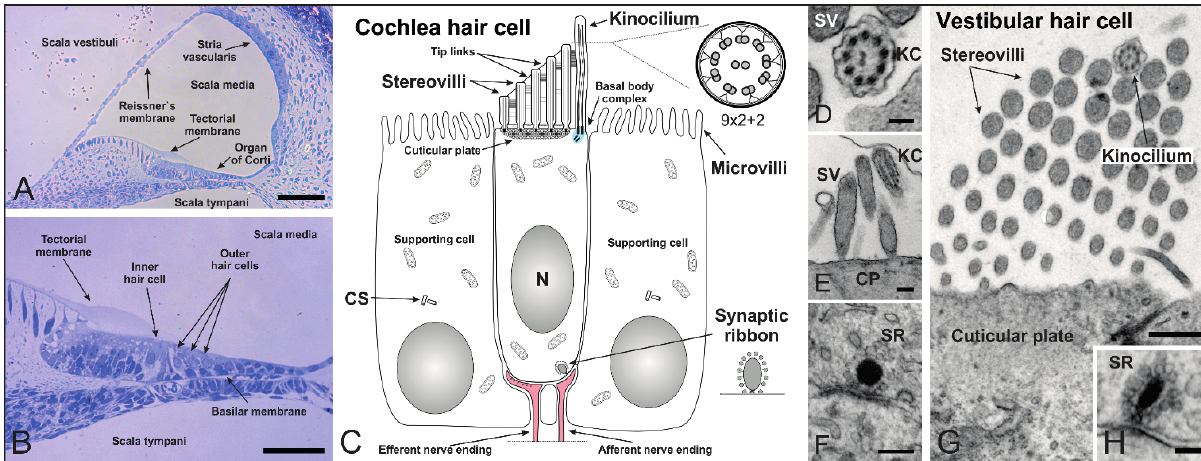
Figure 2. Cilia in the inner ear of mammals shortly after birth. ( A , B ) Cross section of a mouse cochlea at P5 (postnatal day 5) stained with toluidine blue. The cochlea is divided into three fluid-filled compartments: scala vestibuli, scala tympani and scala media. Scala vestibuli (containing perilymph) is separated from the scala media (containing endolymph) by the Reissner’s membrane, while scala media and scala tympani (containing perilymph) are separated by the basilar membrane. The basilar membrane contains the Organ of Corti with sensory hair cells responsible for auditory function. The hair cells are arranged in four rows along the entire length of the cochlea—three rows of outer and one row of inner hair cells. The tectorial membrane responsible for their direct (outer hair cells) and indirect (inner hair cells) activation covers the hair cells; ( C ) Schematic of a mammalian cochlear hair cell shortly after birth. Hair cells are polarized epithelial mechanosensory cells with a mechanically sensitive organelle at the apical surface, known as stereovilli (SV). Stereovilli are non-motile hair bundles consisting of dozens of specialized F-actin-filled microvilli graduated in length to form a staircase-like structure. Within their V-shaped orientation stereovilli are connected by extracellular linkages called tip links. The longest stereovilli is closest to a single genuine microtubule-based cilium, the kinocilium with a (9 × 2 + 2) microtubule configuration (which begins to regress at around P8 in the mouse). Hair cells are surrounded by non- sensory supporting cells with microvilli on their apical surface; ( D – H ) Transmission electron micrographs of a mouse cochlea; ( D ) Cross-section of a kinocilium (KC) showing the (9 × 2 + 2) structure; ( E ) Longitudinal section of stereovilli and the kinocilium on the apical surface of an inner hair cell; ( F ) Immature synaptic ribbon (SR) of an inner hair cell with the typical electron-dense sphere surrounded by synaptic vesicles; ( G ) V-shaped orientation of stereovilli and the kinocilium on a vestibular hair cell; ( H ) Cross-section of a synaptic ribbon in a vestibular hair cell. CS: centrosome. CP: cuticular plate. Scale bars: 50 µm ( A , B ), 100 nm ( D , H ), 200 nm ( E , F ), 500 nm ( G